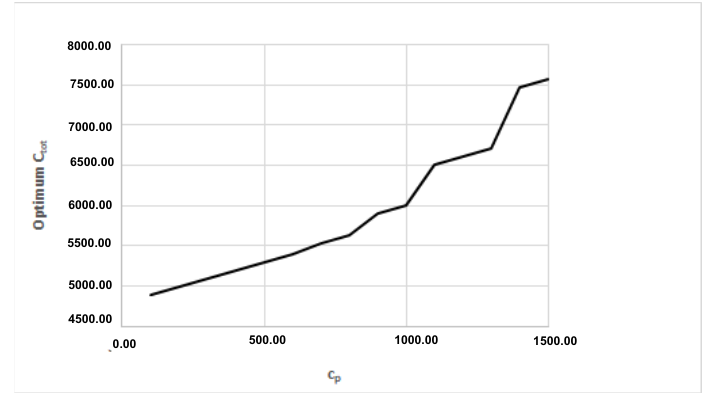
Figure 12. Variations of optimum C tot per c p .